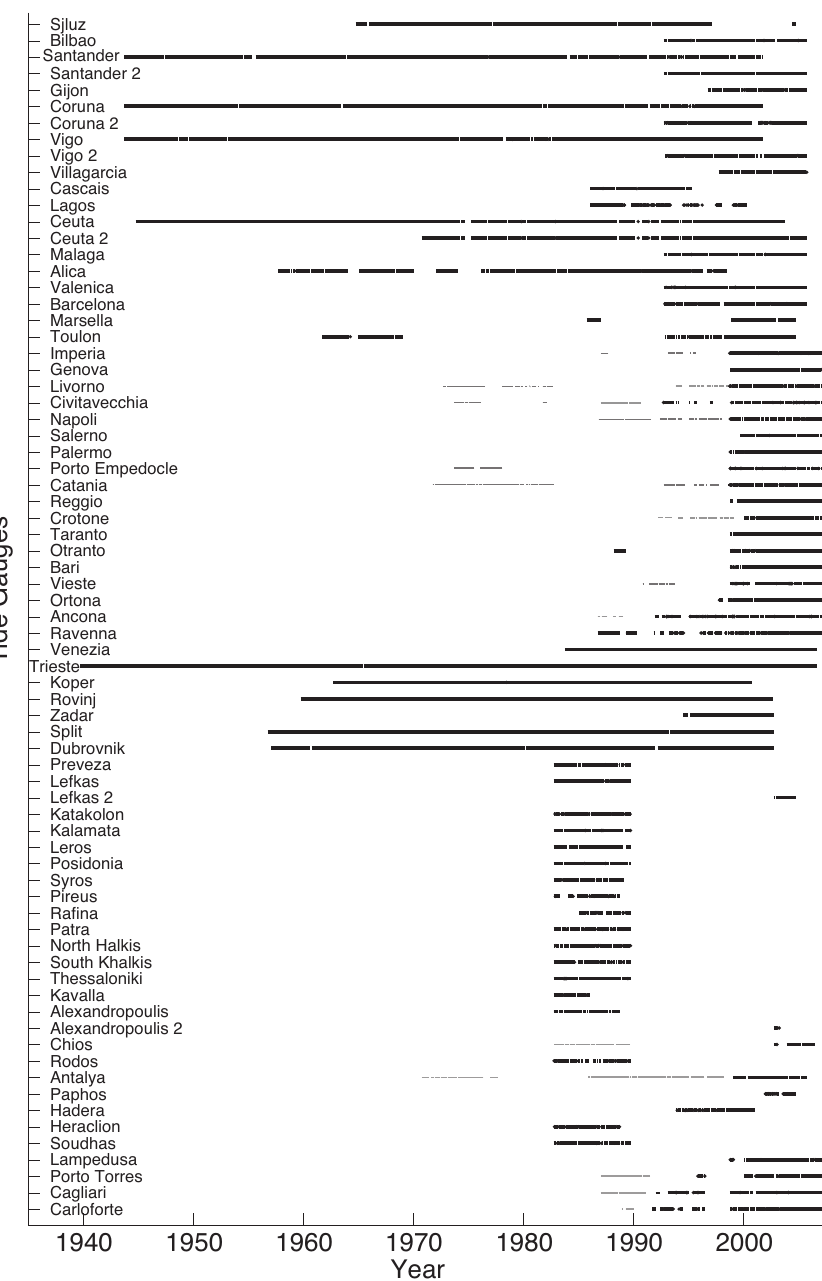
Figure 2. Available hourly tide gauge observations. The thin lines indicate datum shifts within the time series records and consequently the record was split into more than one sub-records.